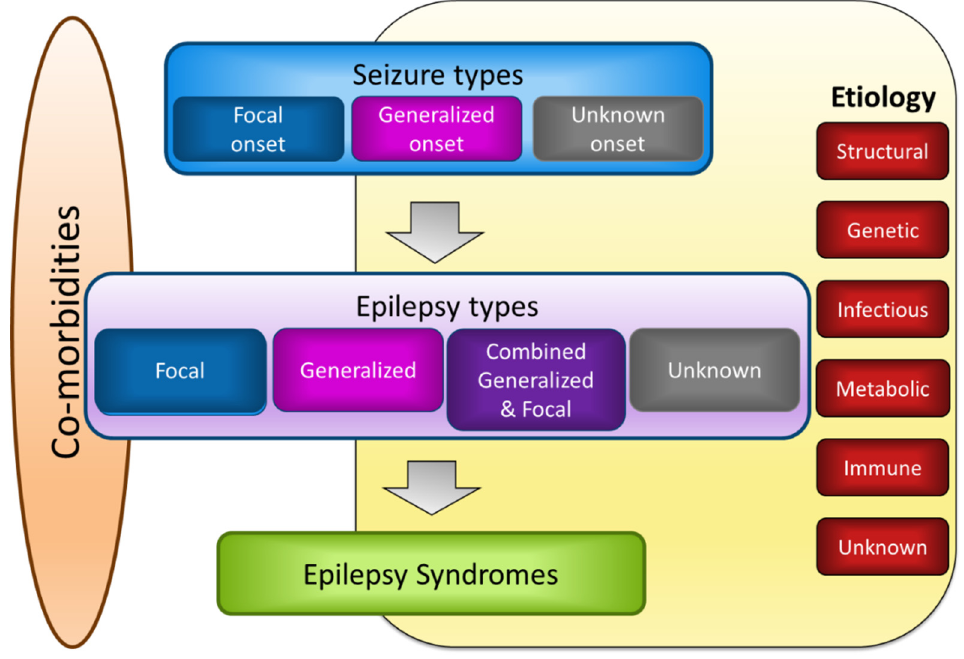
Figure 2. ILAE guidelines for the classification of epilepsies. Reprinted with permission from Wiley [3].